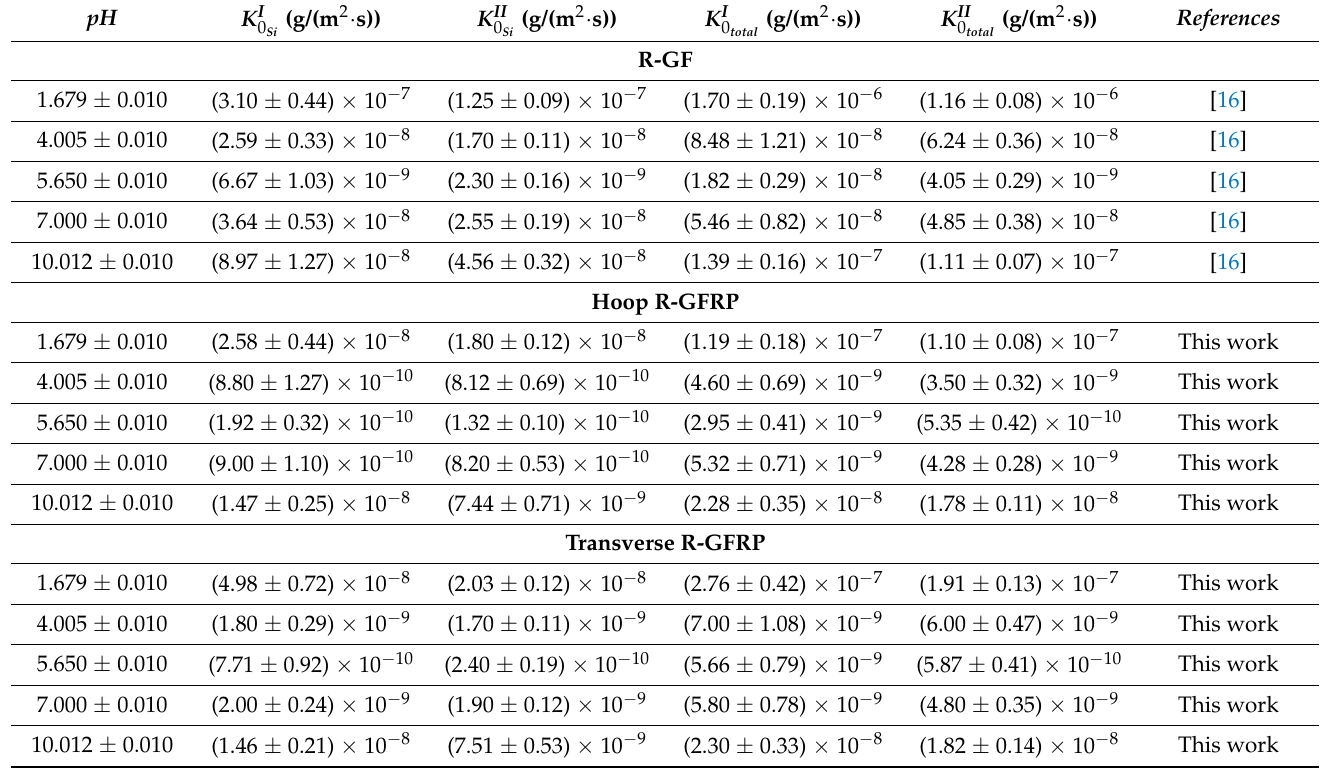
Table 2. The glass dissolution rate constants were obtained via regression of the experimental data of GFRPs using the DCZOK model for Si and total mass loss at 60 ◦ C and various pH values for both hoop and transverse